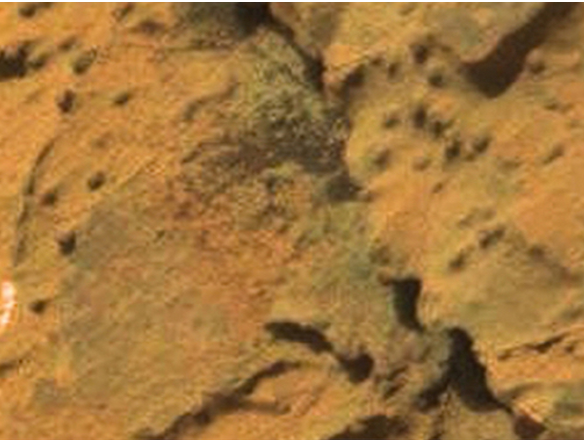
Figure 9. Mars. Sol 853. Thick-layered clumps of algae-like sub- stance and "tubular" specimens on top of and adjacent to speci- mens resembling fossilized bacterial mats, and adjacent to "dim- pled" lichen-like organisms. Photographed in Gale Crater. (Repro- duced with permission from Joseph et al.